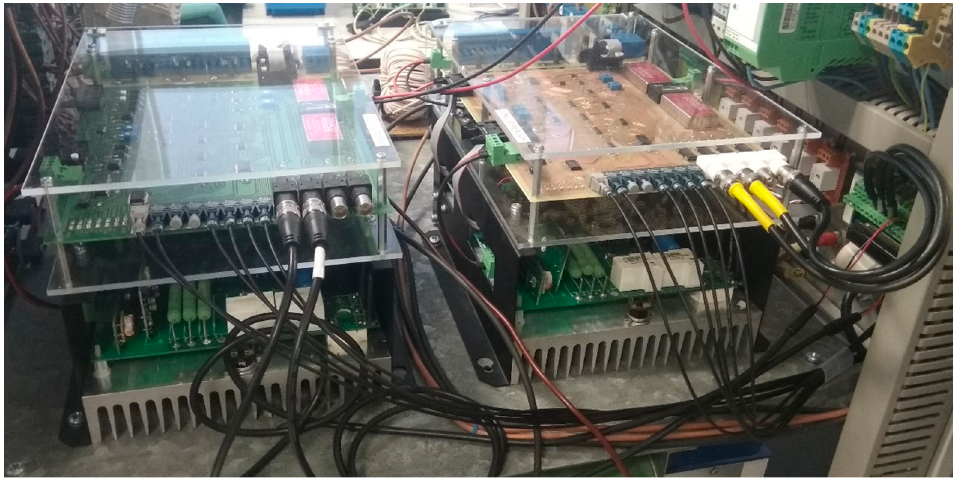
Figure 18. Battery and supercapacitor storage system DC/DC converters.